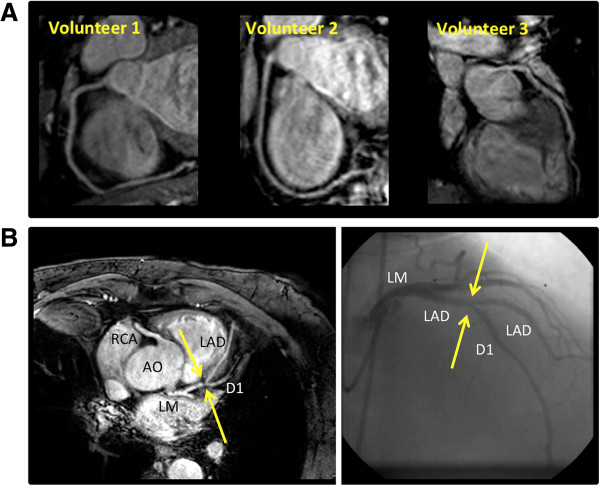
Double oblique single-breathhold 3D bSSFP coronary magnetic resonance angiograms of the right coronary artery and left anterior descending in three healthy volunteers (A) and in a 66-year-old patient (B) with 50-70% lesion at the diagonal branch of the LAD identified using diagnostic x-ray angiogram. AO: Aorta, RCA: Right Coronary Artery. LM: Left Main Artery. LAD: Left Anterior Descending Artery. D1: First Diagonal Branch. MRA Images were multi-planar reformatted.